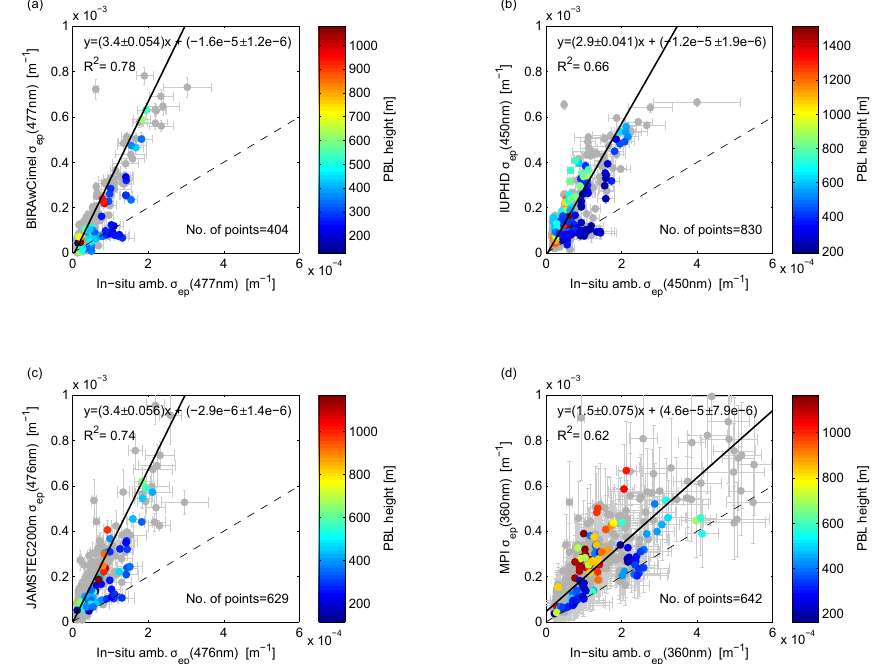
Fig. 9. Same as Fig. 8, but here the color code denotes the planetary boundary layer height measured by the ceilometer (grey points: no quality assured PBL data